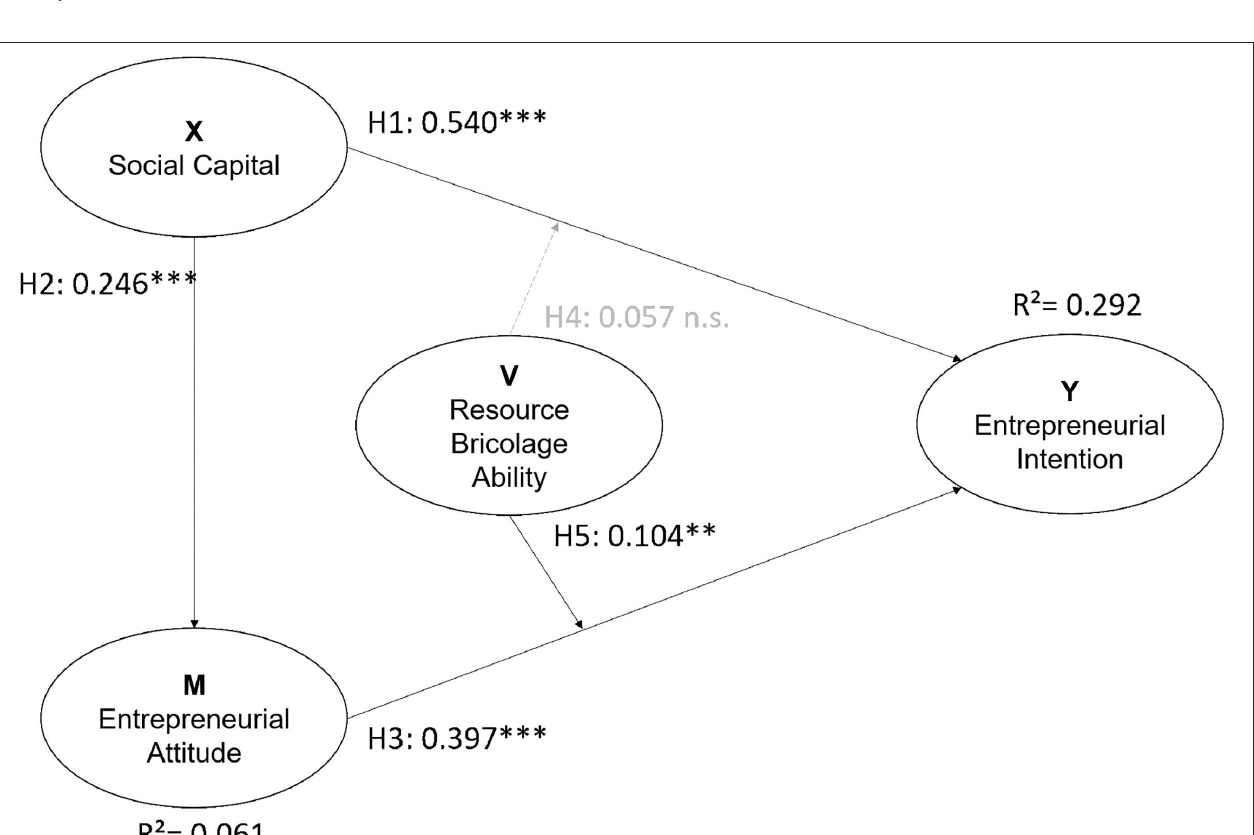
hypothesized model to explore the relationships among social capital, resource bricolage ability, entrepreneurial attitude, and entrepreneurial